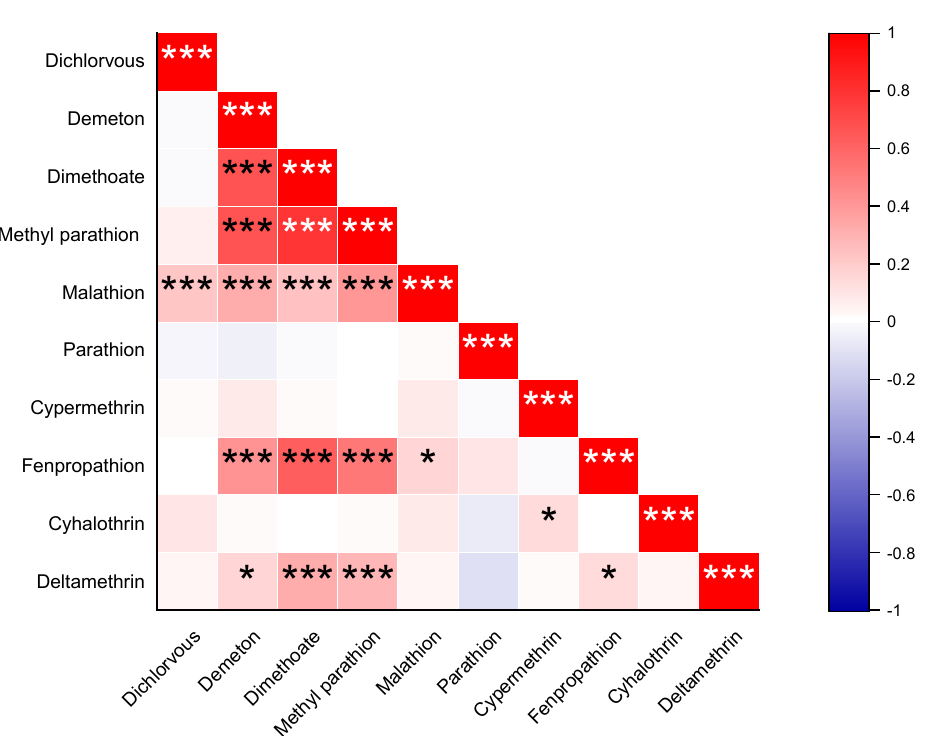
Figure 2. Correlation analysis between the 6 OPPs and 4 PYs in agricultural soils of the PRD region. * Indicates significance level at 0.05. *** Indicates significance levels at 0.001.